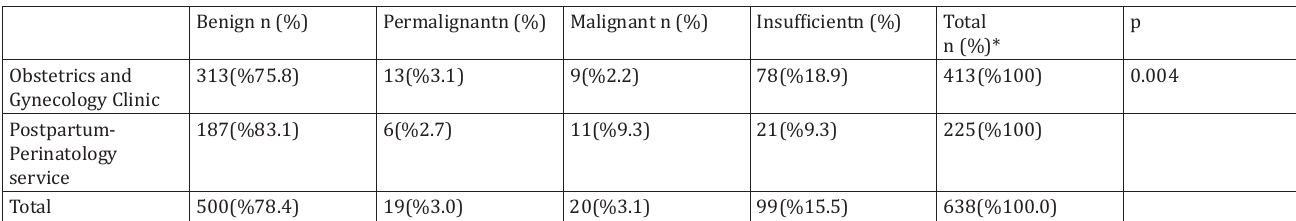
Distribution of pathology results according to the unit that sent the biopsy